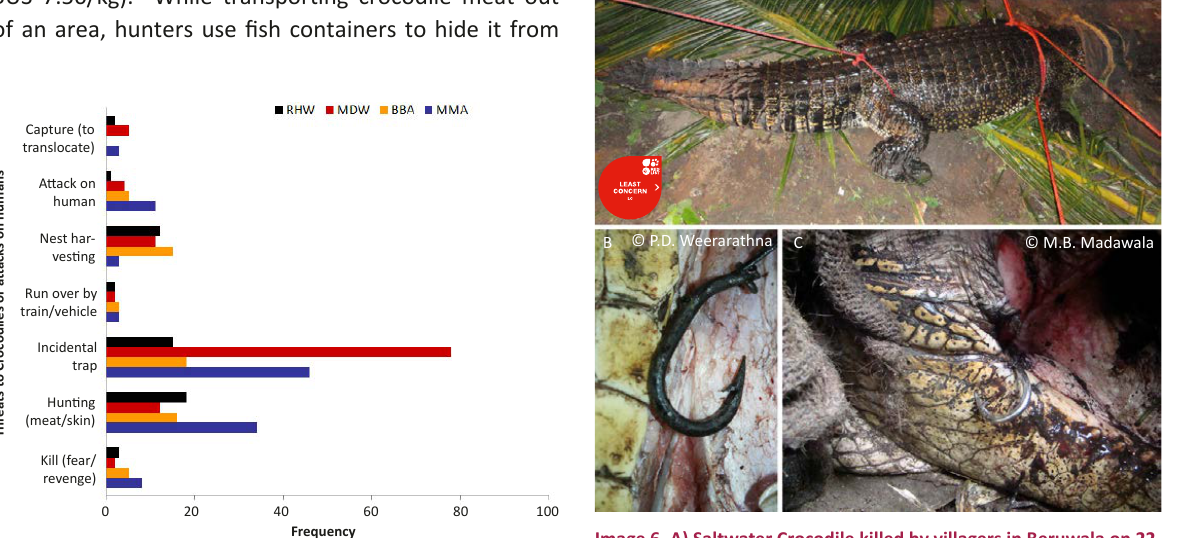
Image 6. A) Saltwater Crocodile killed by villagers in Beruwala on 22 December 2011. The animal was injured by two hooks, one in the stomach (B) and one in the mouth